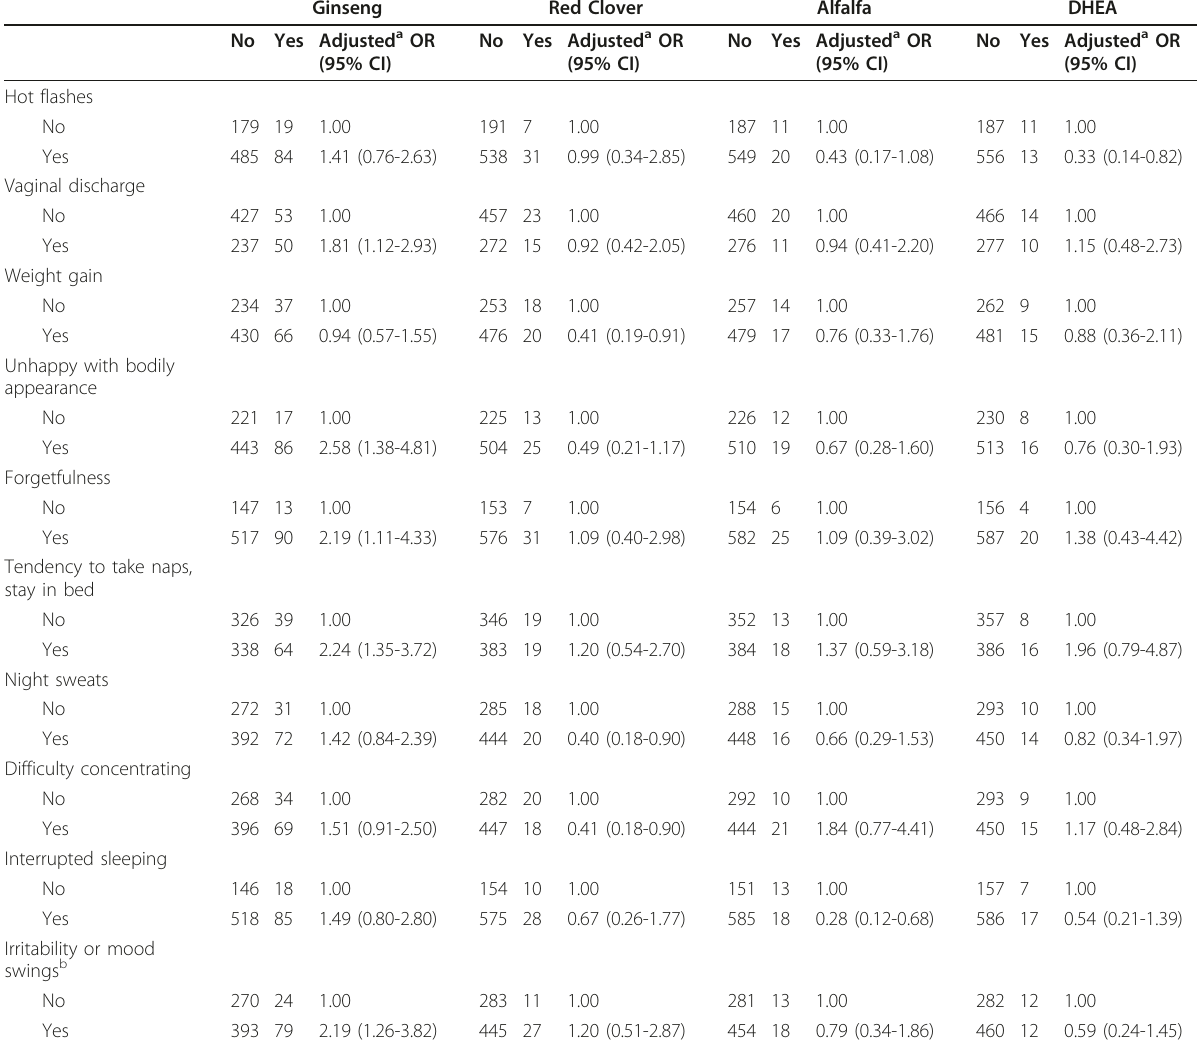
Table 4 Adjusted a OR (95% CI) for the association between estrogenic botanical supplement use and hormone-related symptoms during last years of 30-month survey Ginseng Red